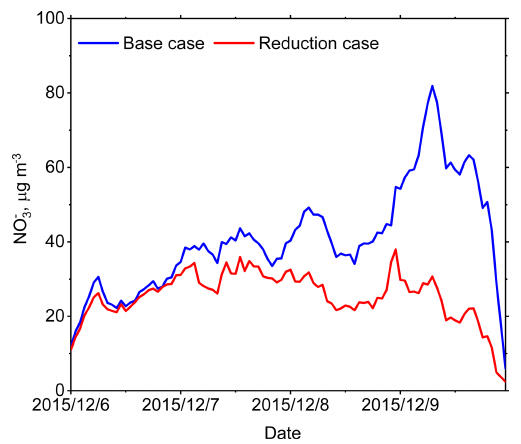
Figure 1. A comparison of particulate nitrate (NO − base (blue line) and emission reduction cases (red line) simulated by the ISORROPIA-II model in this severe haze